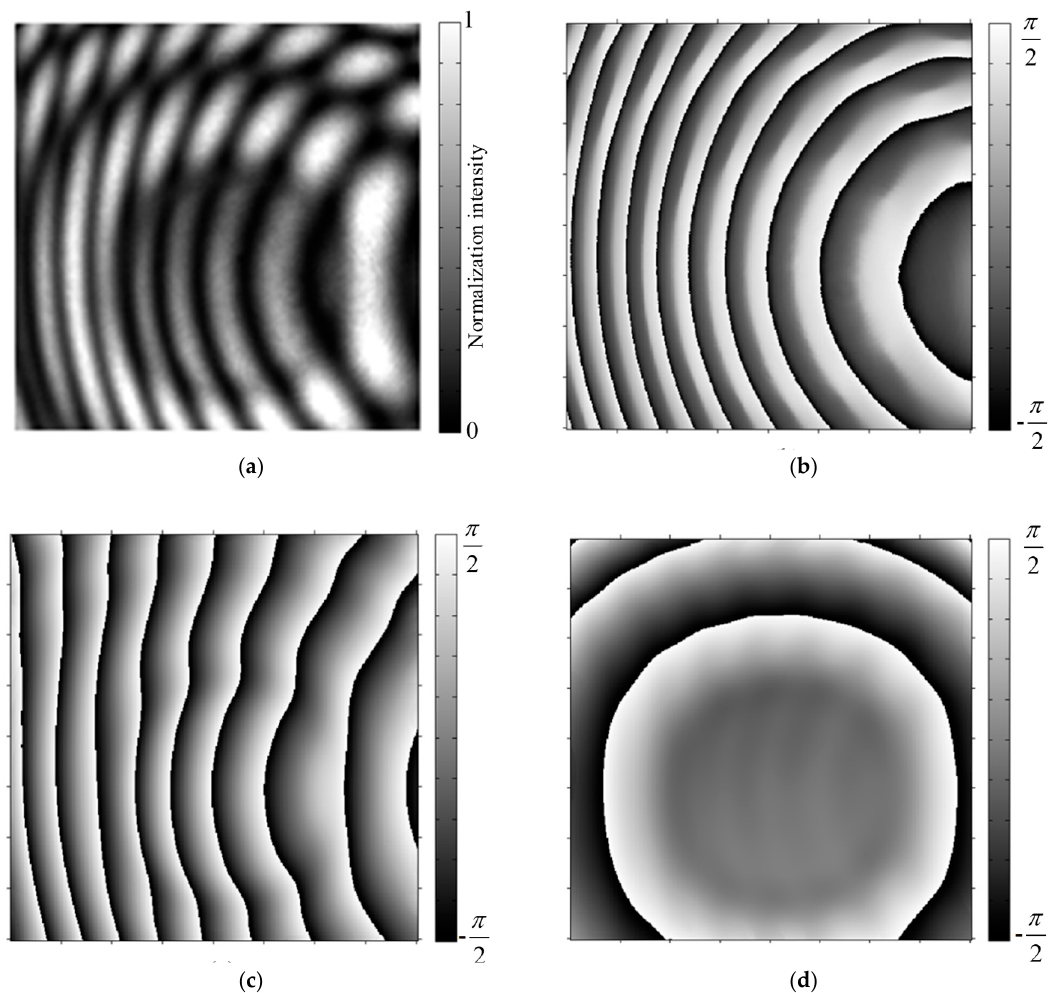
Figure 5. Distributions of the registered and processed signals obtained in the experiment. ( a ) The fringe pattern from both surfaces of the transparent plate at the initial wavelength; ( b ) wrapped phase map of the front surface after the windowed Fourier transform (WFT) filter was applied; ( c ) wrapped phase map of the rear surface after the WFT filter was applied; ( d ) wrapped phase map of variation in the thickness after the WFT filter was applied.